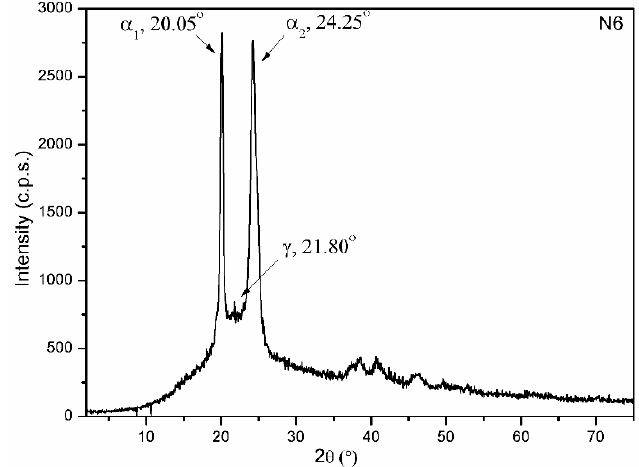
Figure 6. PXRD diagram of sample N6.